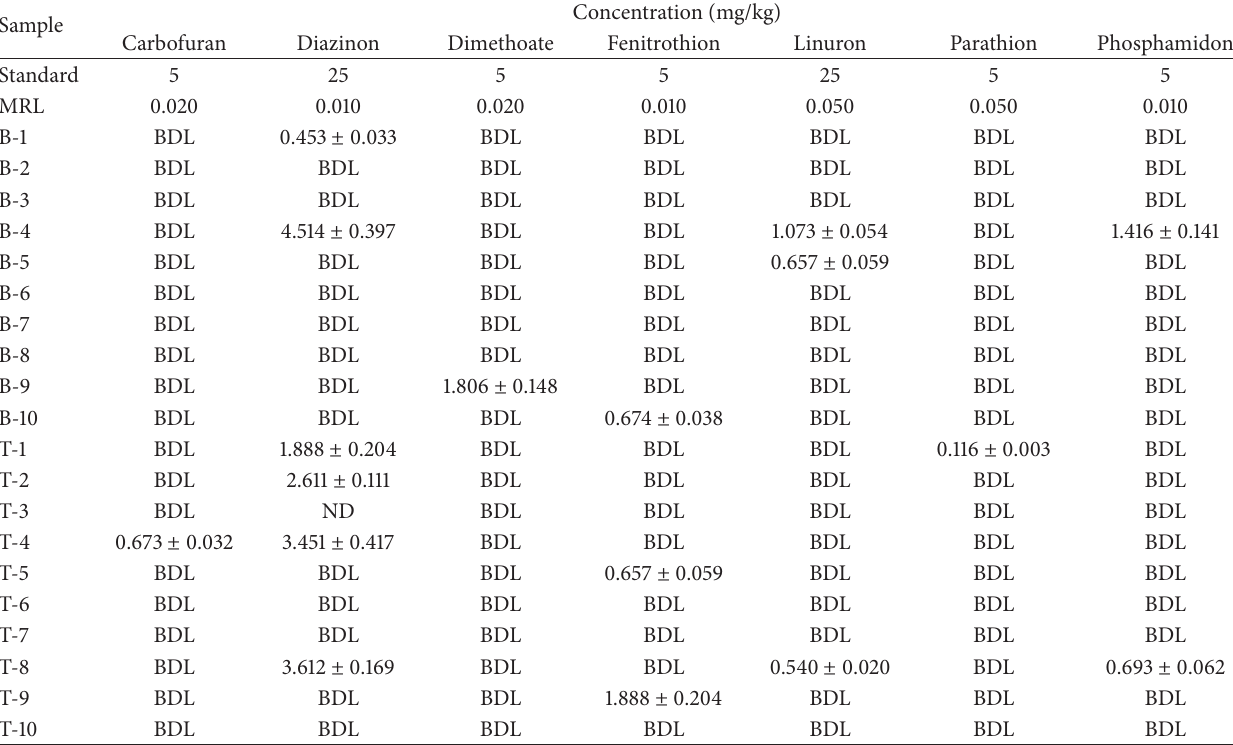
Table 1: Residual levels of carbofuran, diazinon, dimethoate, fenitrothion, linuron, parathion, and phosphamidon in eggplant and tomato samples.